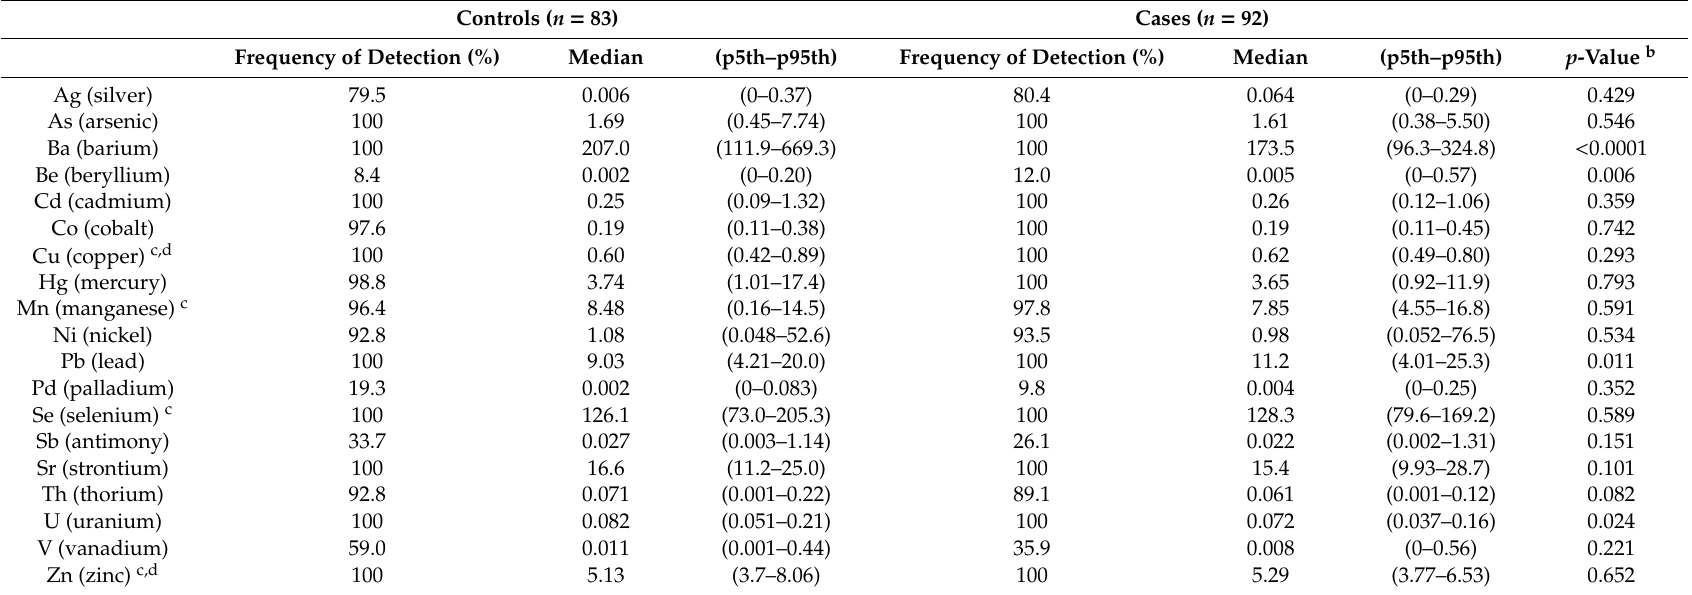
Table 2. Blood concentration (ng / mL) of inorganic elements including in the ATSDR’s priority pollutant list (2017) a , among cases and controls. Controls ( n =